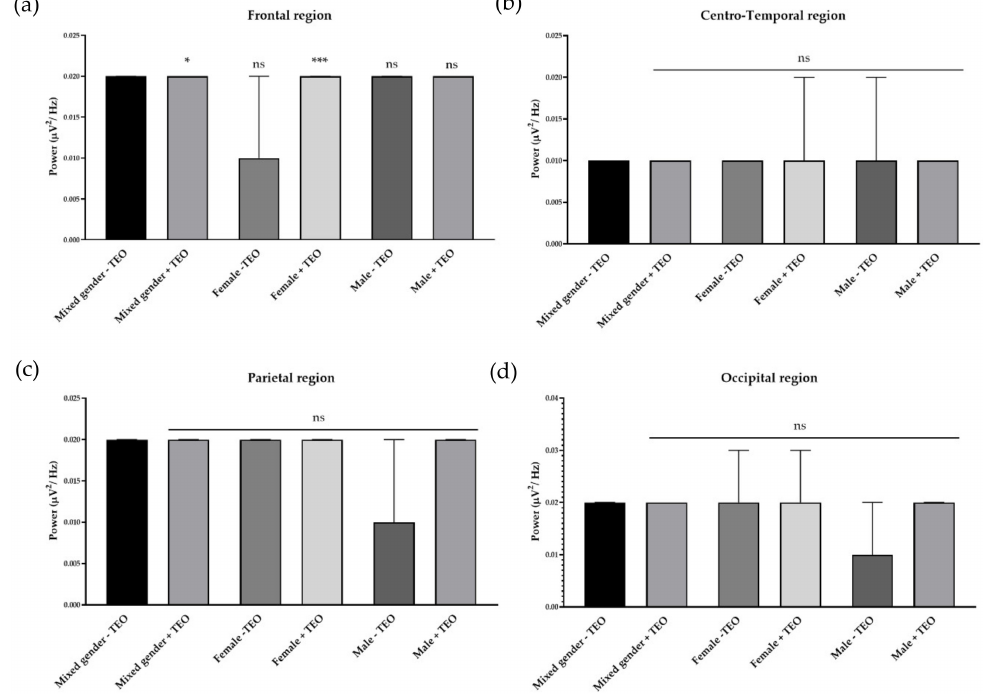
Figure 6. E ff ects of tangerine essential oil on mid beta (17 Hz): ( a ) Frontal region; ( b ) Centro-Temporal region; ( c ) Parietal region; ( d ) Occipital region. p value: ns ≥ 0.05, * < 0.05, *** <